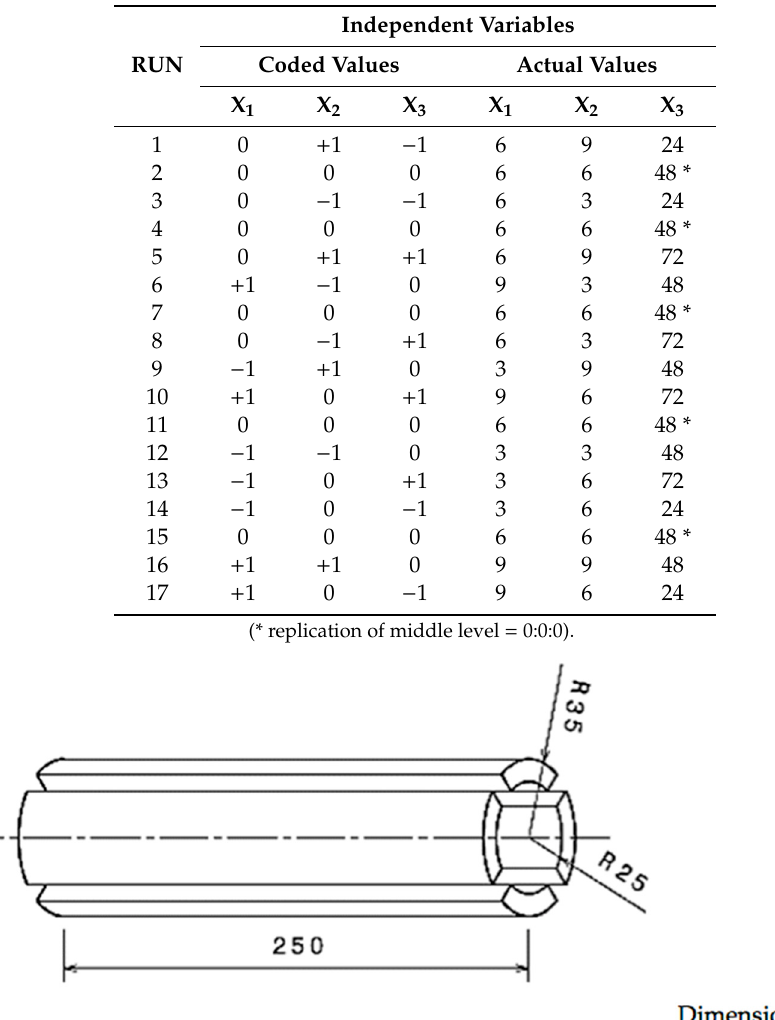
4 of 20 Table 2. Experimental trials derived from Design-Expert Software.